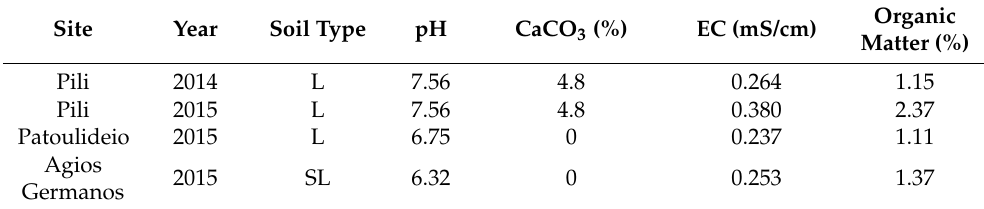
Table 2. Soil physicochemical properties in the different cultivation